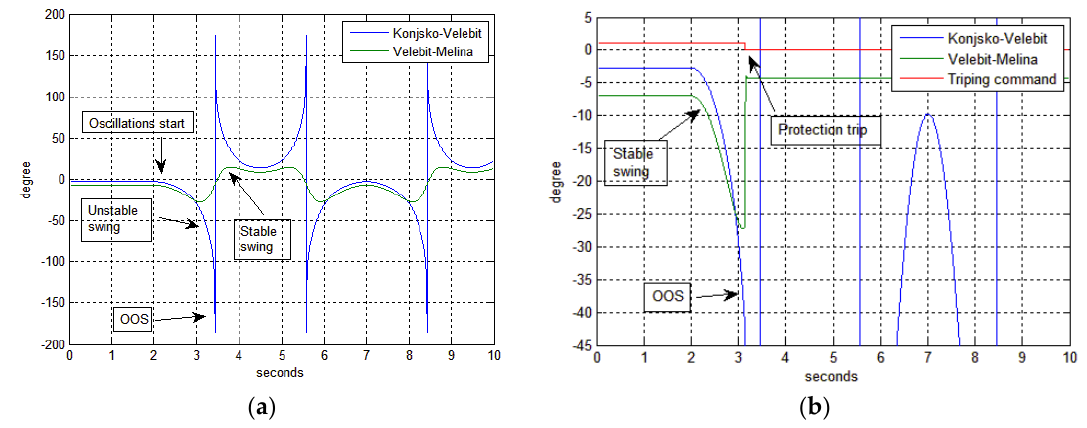
Figure 14. Active power oscillations on two 400 kV lines with voltage angle difference Δ φ and protection operations: ( a ) On line Konjsko-Velebit there is an out-of-step (OOS) conditions and on line Velebit-Melina there is a power swing condition; and, ( b ) Detail presenting protection activations when protection setting is reached and tripped the Konjsko-Velebit line while Velebit-Melina remained in operation.